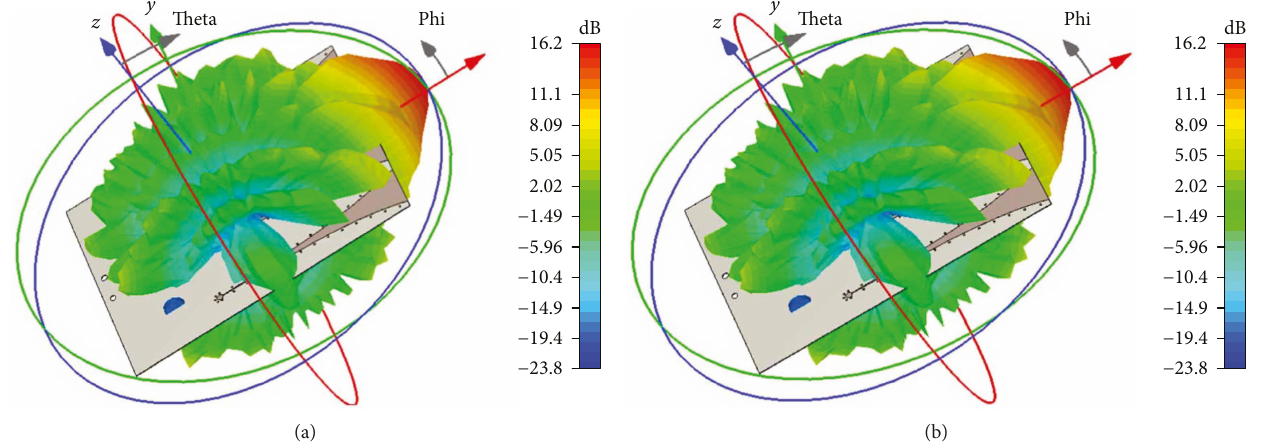
Figure 11: 3D gain of the proposed 1 × 4 linear Vivaldi antenna array at 28GHz and 38GHz.